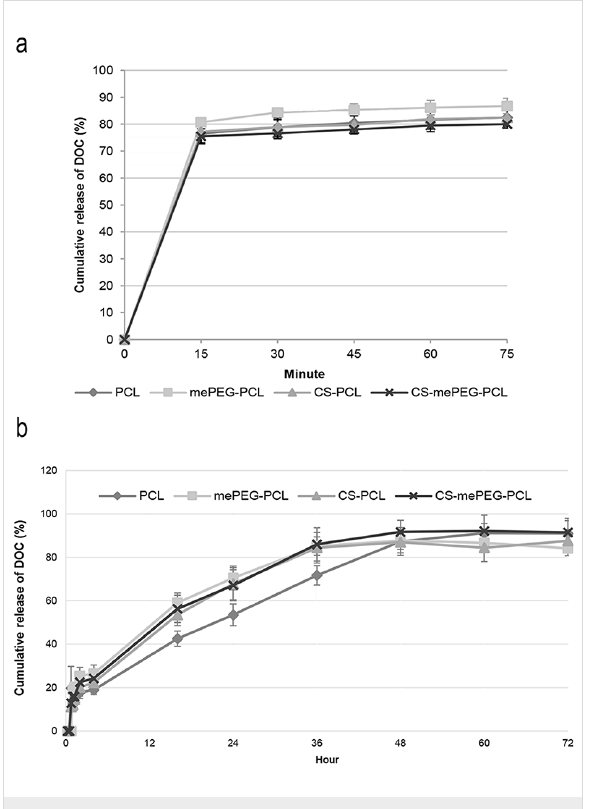
Figure 5: Cumulative release profile of DOC from nanoparticles (a) and nanoparticulate DOC from HpC films (b) ( n = 3, ± SD).